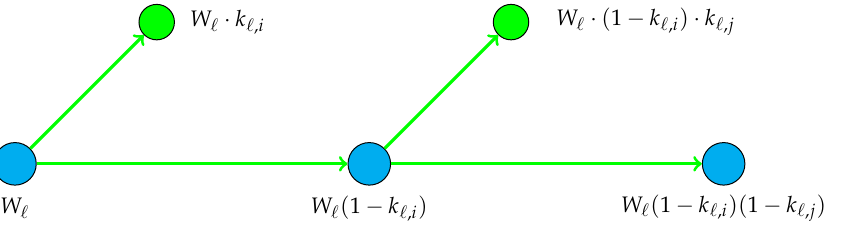
Figure 5. Sequential processing of ABs.